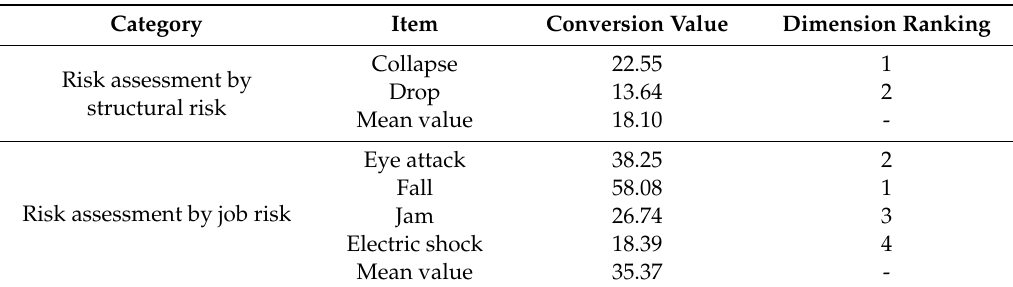
Table 12. Risk calculation results by risk type.